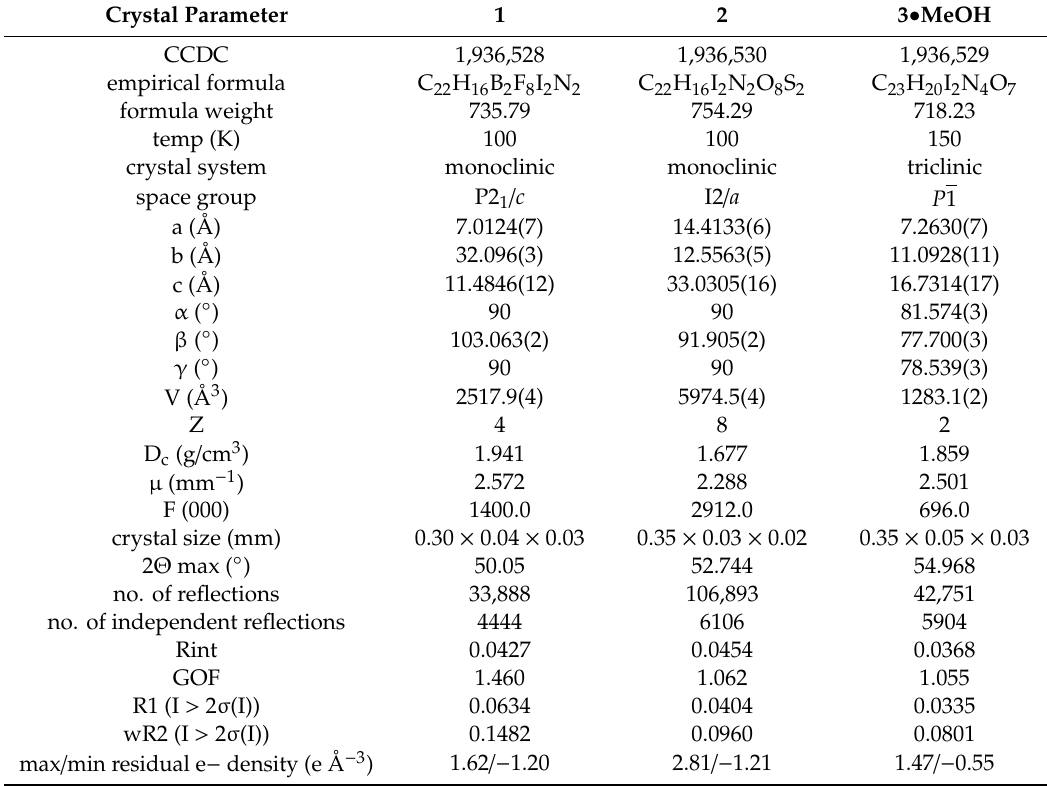
Table 1. X-ray crystallographic